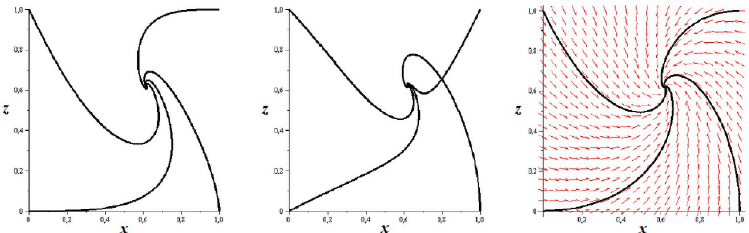
Fig 5. Comparison of the dynamics of the full System (8) and simplified System (10) for all the model parameters equal to 1: projection of the phase space portrait for (8) with initial values for y : (left) taken as 0 except for one case where x (0) = y (0) = z (0) = 1; (middle) vary from 0 through 0.5 to 1; phase space portrait for (10) (right). Note that the cross-section of trajectories visible in middle graph is a result of the projection of R 3 into R 2 .